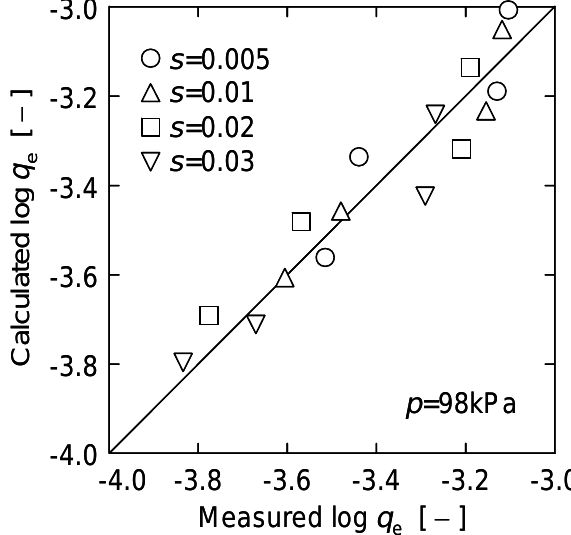
Figure 8. Comparison between calculated and measured